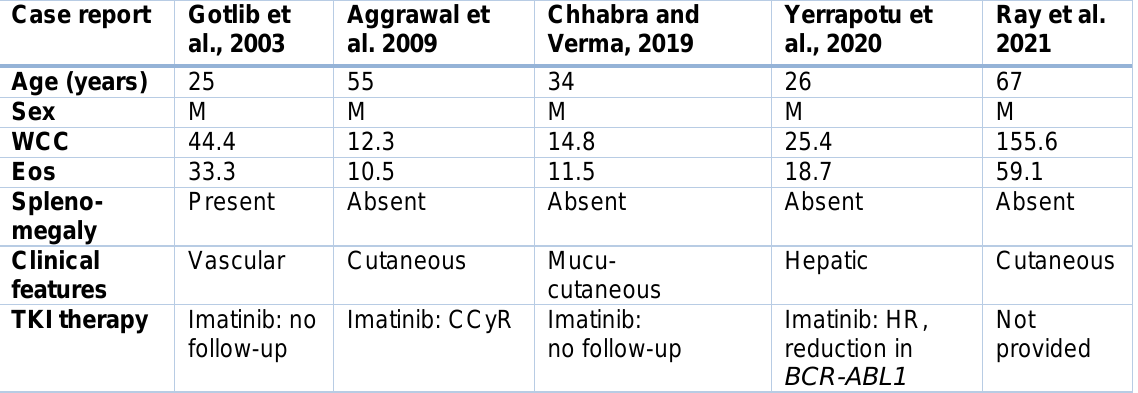
Table 1: Presenting features of patients with the eosinophilic variant of chronic myeloid leukemia Case